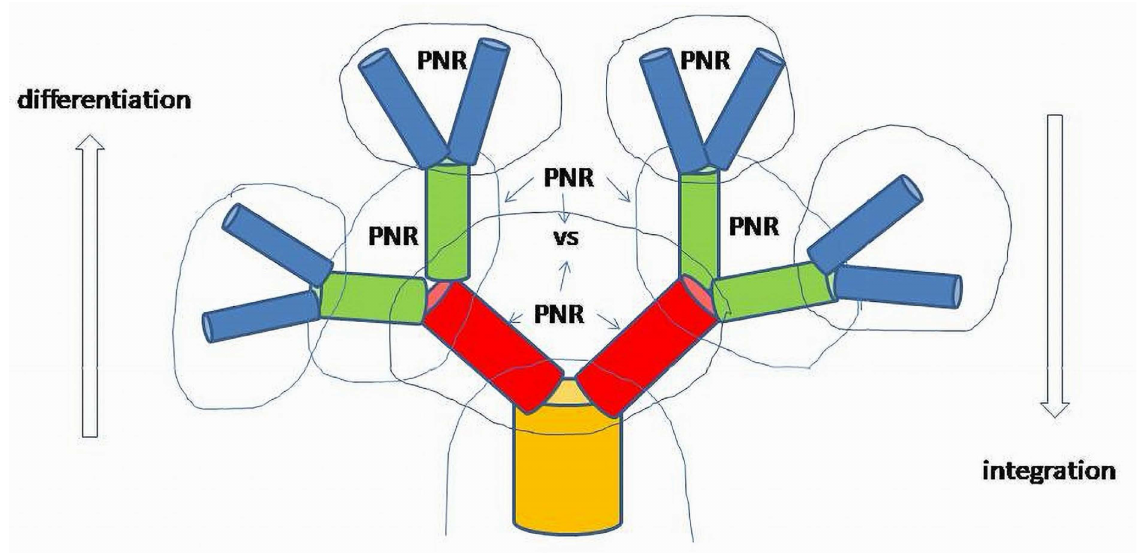
Figure 8. Hierarchical organization of biologic systems and phylo-ontogenetic tree. Each branch is a self-regulating BS (functional module). Same-colored branches represent differentiated systems linked by PNR patterns. PNR: Positive feedback; Negative feedback; Reciprocal